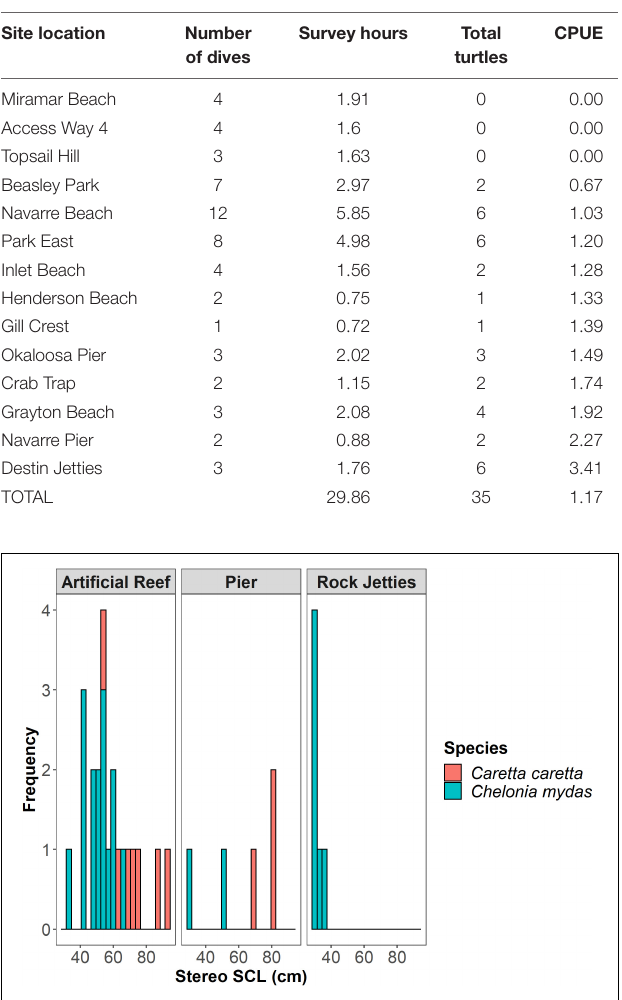
FIGURE 2 | Size-frequency distribution of sea turtle species across our study sites in the northeastern Gulf of